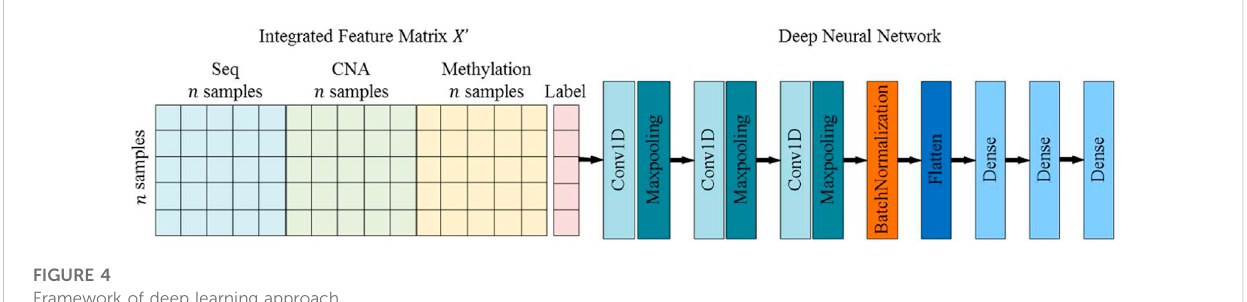
FIGURE 4 Framework of deep learning